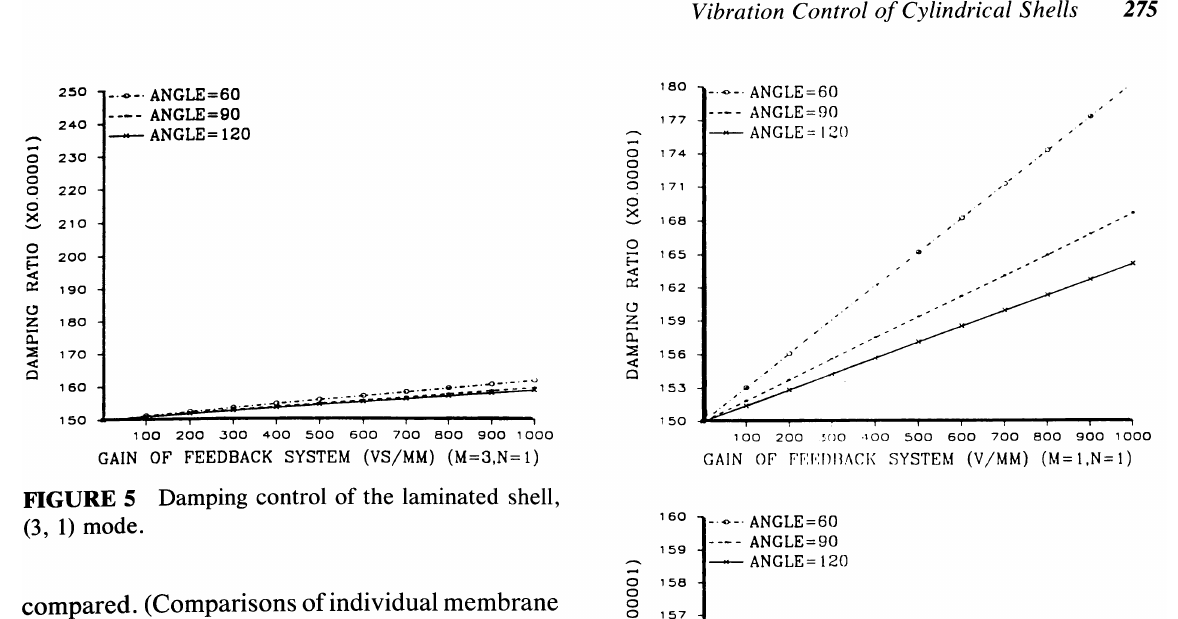
FIGURE 5 Damping control of the laminated shell, (3, 1) mode.